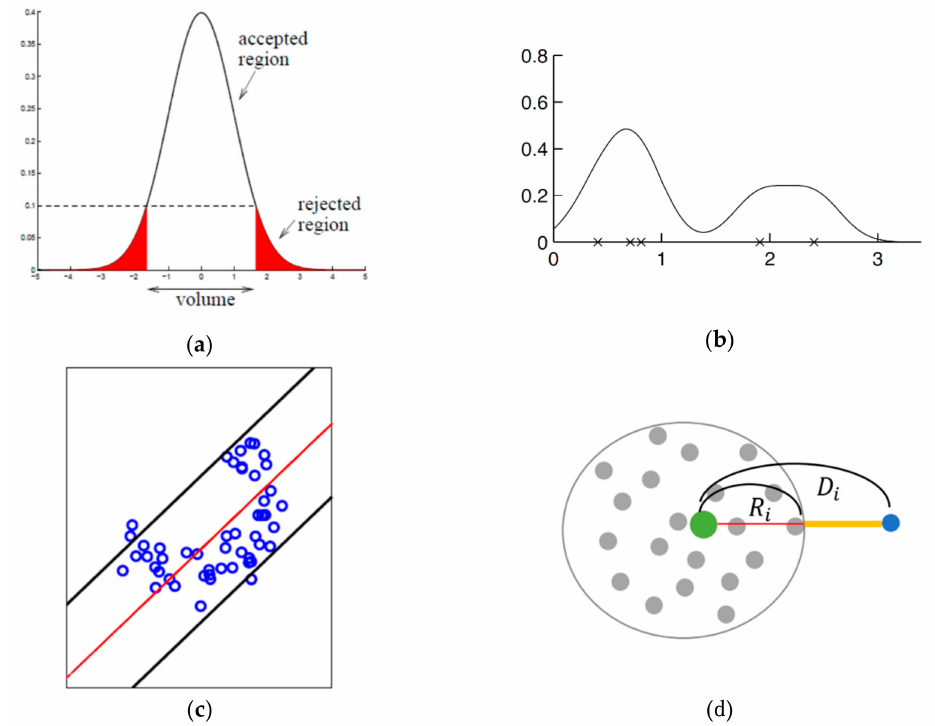
Figure 4. Four anomaly detection algorithms used in this paper. ( a ) Gaussian density estimation, ( b ) Parzen window density estimation (reprinted from Alpaydin (2014)), ( c ) Principal component analysis (PCA), and ( d ) K-means clustering